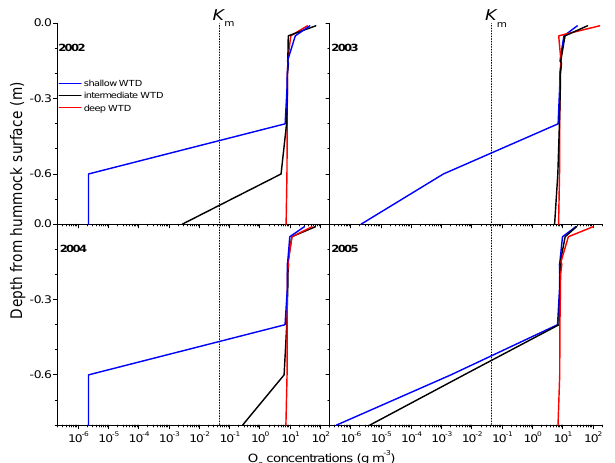
Fig. 11. Vertical profile distributions of peat soil aqueous oxygen concentrations ([O 2s ]) simulated under hummock surface during shallow (DOY 15, 55, 25 and 55 of 2002, 2003, 2004 and 2005 respectively), intermediate (DOY 135, 160, 195 and 135 of 2002, 2003, 2004 and 2005 respectively), and deep (DOY 265, 265, 305 and 255 of 2002, 2003, 2004 and 2005 respectively) water table depth (WTD) hydroperiods over a drainage affected tropical peat swamp forest at Palangkaraya, Indonesia. K m =Michaelis-Menten constant (0.064gm − 3 ) for microbial, root and mycorrhizal uptake (A17a, C14c) in ecosys